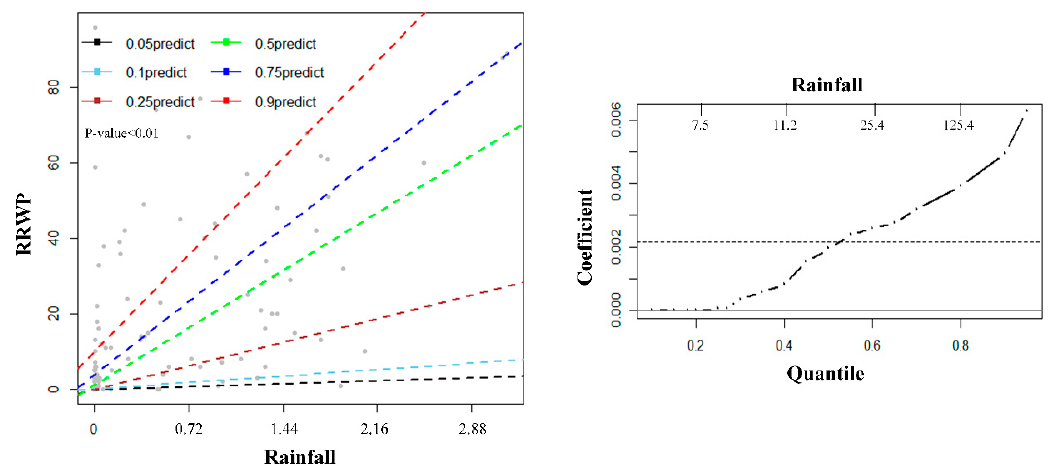
Figure 9. Quantile regression estimates of the relationship between the RRWP and the rainfall amount at the city scale.